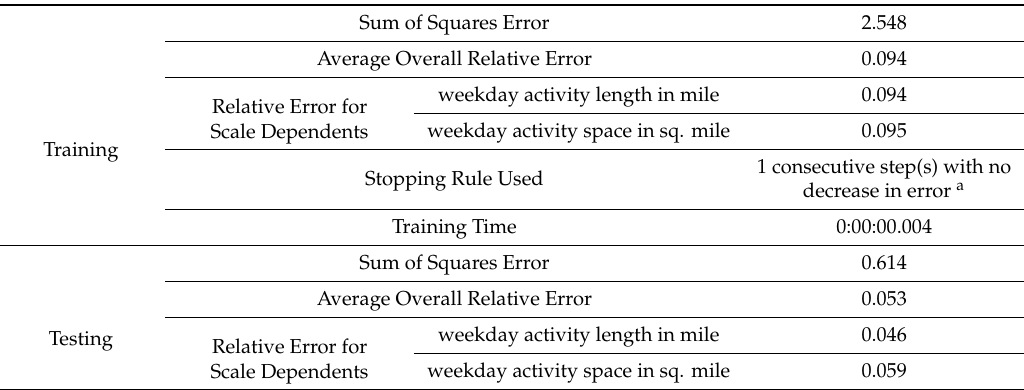
Table 15. Model Summary.